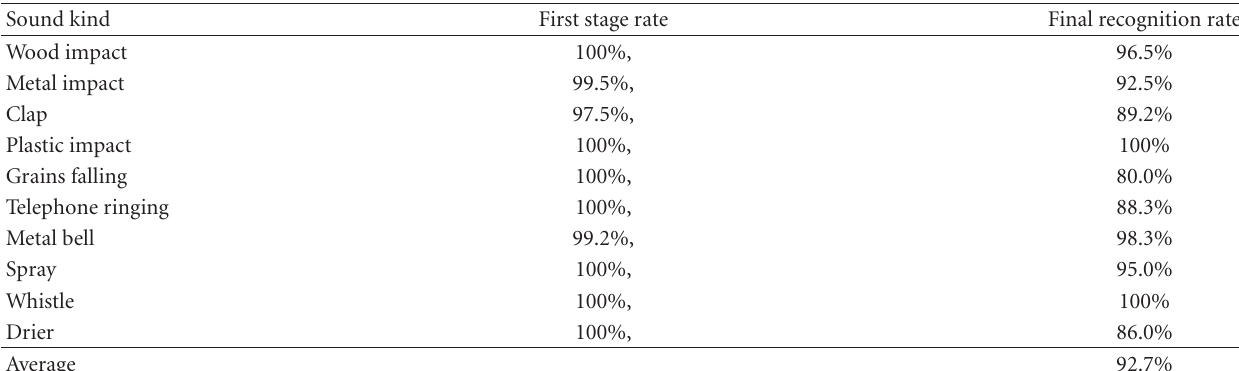
Table 4: Results of recognition experiments for environmental sounds in the RWCP